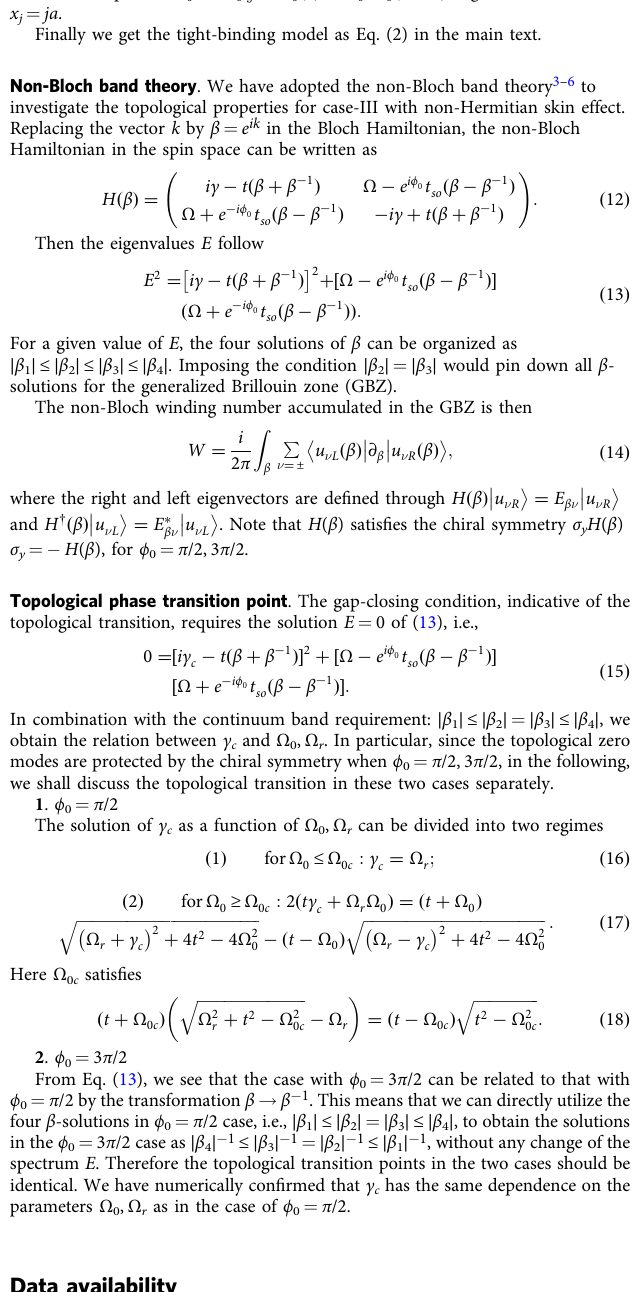
q ffiffiffiffiffiffiffiffiffiffiffiffiffiffiffiffiffi ffiffiffiffiffiffiffiffiffiffiffiffiffiffiffiffiffiffiffiffiffiffiffiffiffiffiffiffi Ω 2 t 2 (cid:2) Ω 2 r þ 0 c